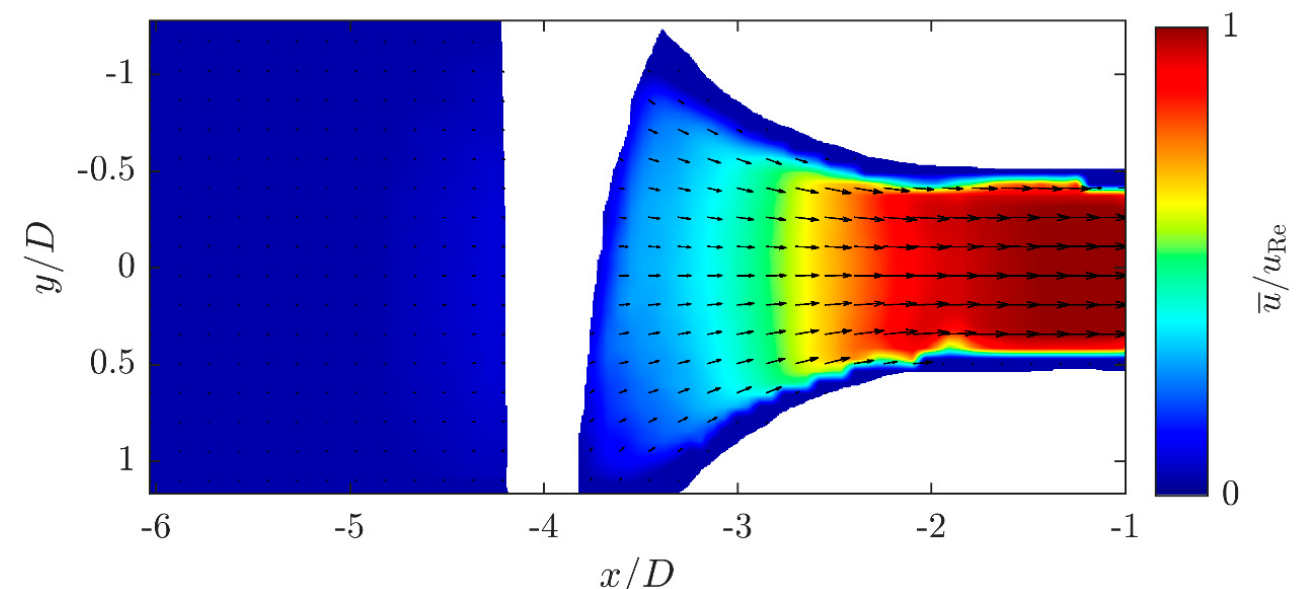
Figure 7. Velocity field of the continuous phase inside the orifice at the Reynolds number Re = 2000, normalized by the theoretical orifice velocity measured by 2D2C PIV.